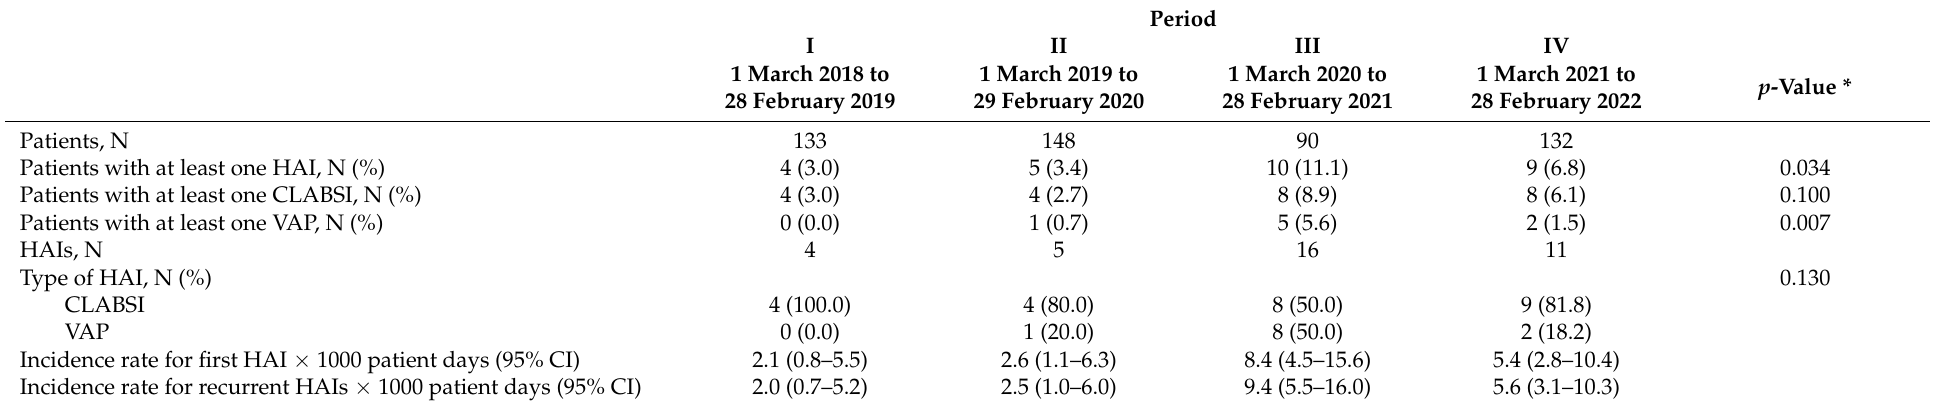
Table 2. Key characteristics of healthcare-associated infections (HAIs) diagnosed (N = 36) among patients admitted to the neonatal intensive care unit of Umberto I teaching hospital of Rome between March 2018 and February 2022 (N = 503) by study period. Results are expressed as number (percentage, %) or mean (standard deviation,